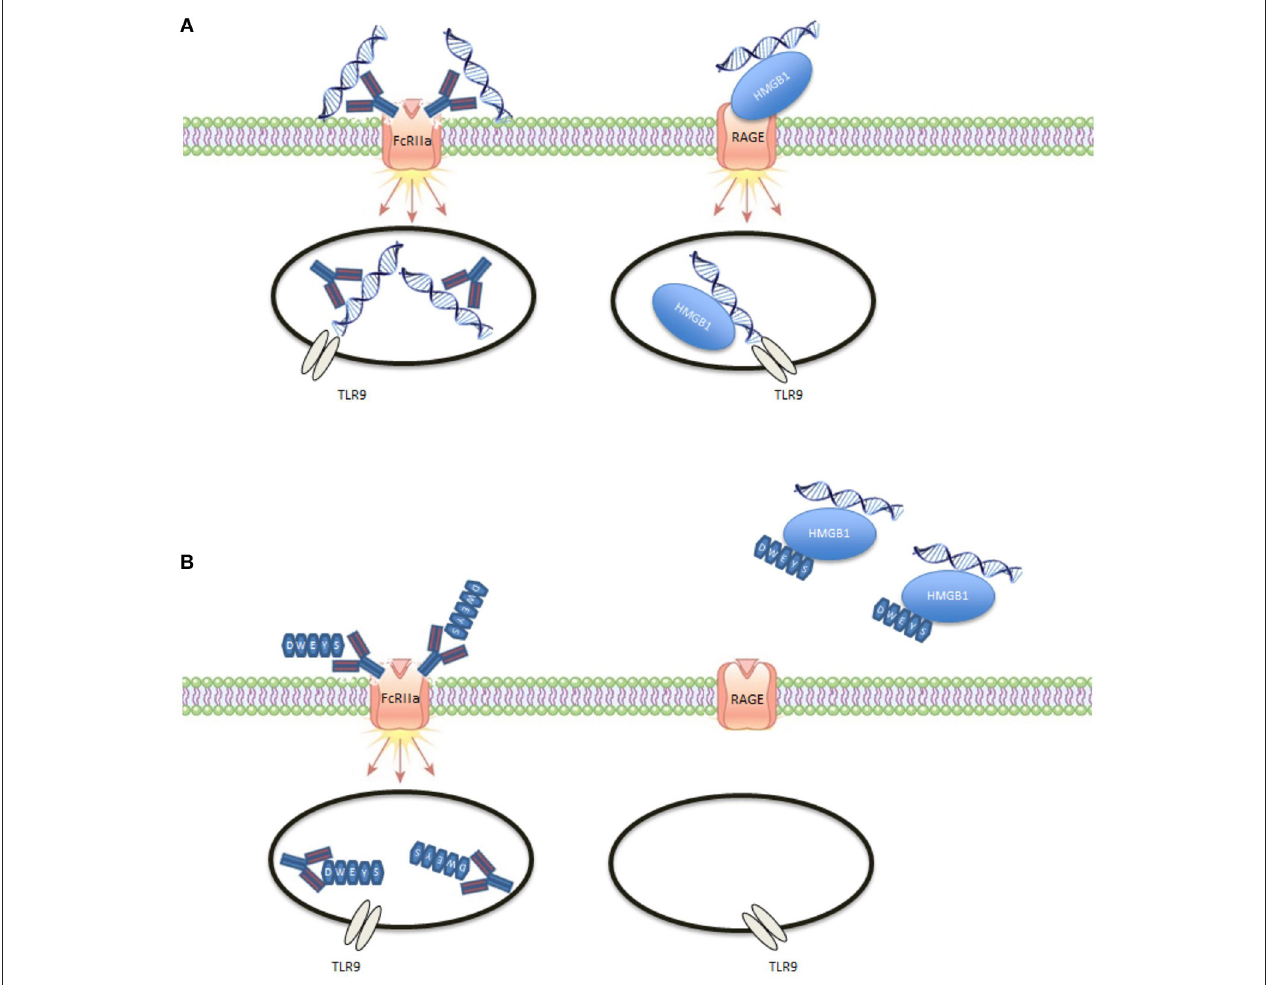
FIGURE 6 | Illustration of DWEYS mediated inhibition. (A) DNA can enter endosomes as ICs through FcRlla or complexed to HMGB1 through RAGE. (B) DWEYS replaces DNA in DNA containing ICs and blocks the interaction of HMGB1 with